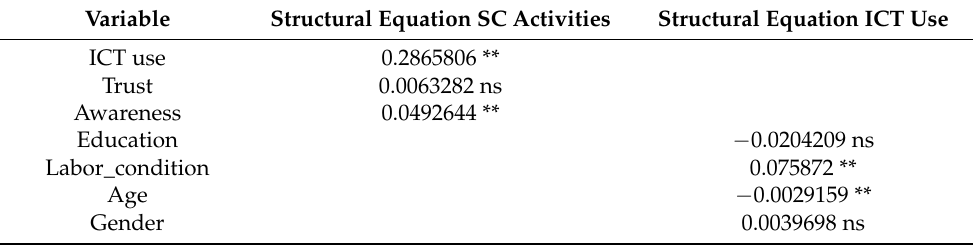
Table 6. Structural models. Notes: ns means not significant; ** significant at 5% level. Source: own